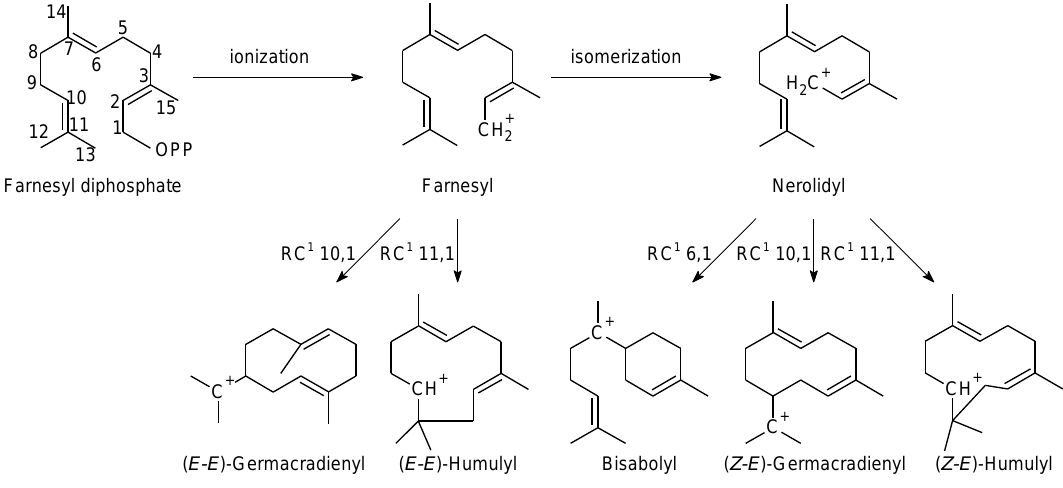
Figure 1. Scheme of cationic first cyclization precursor for the detected sesquiterpenes ( 1 ring closure) [19].